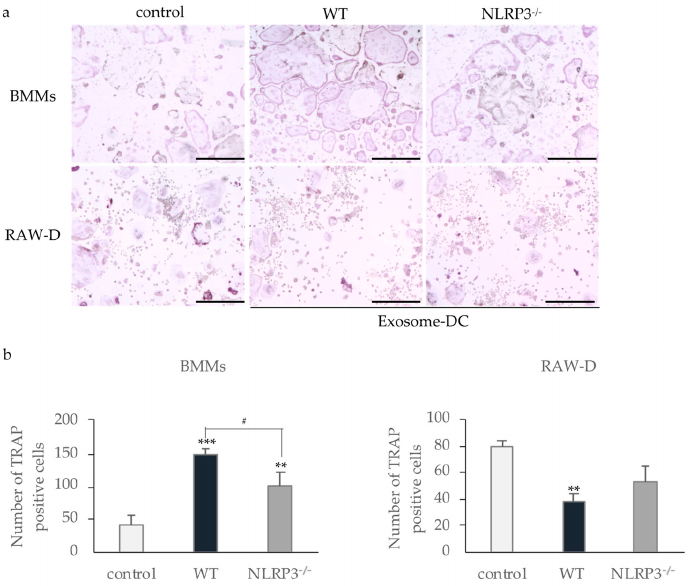
Figure 7. Effect of exosomes from mouse macrophages stimulated with DC. Exosomes were isolated from the culture supernatant of WT or NLRP3 -/- mouse macrophages stimulated with DC. BMMs were incubated with 30 ng/mL M-CSF and 20 ng/mL RANKL for 48 h. Then, the cells were incubated for 24 h with the same concentration of M-CSF, RANKL, and exosomes from WT or NLRP3 -/- mouse macrophages stimulated with DC. RAW-D cells were incubated with 20 ng/mL RANKL for 48 h. Then, the cells were incubated for 48 h with the same concentration of RANKL and exosomes from WT or NLRP3 -/- mouse macrophages stimulated with DC. These cells were subjected to TRAP staining ( a ), and TRAP-positive cells with more than three nuclei were counted ( b ). Scale bar = 250 μ m. The differences between the groups were analyzed by one-way ANOVA followed by a Tukey test for multiple comparisons. ** p < 0.01 *** p < 0.001 compared with the control. # p < 0.05 compared among the test groups. BMM, bone marrow macrophage; DC, dental calculus; exosome-DC, exosome from culture supernatant of the mouse macrophages stimulated with DC; M-CSF, macrophage colony-stimulating factor; TRAP, tartrate-resistant acid phosphatase; WT, wild-type.